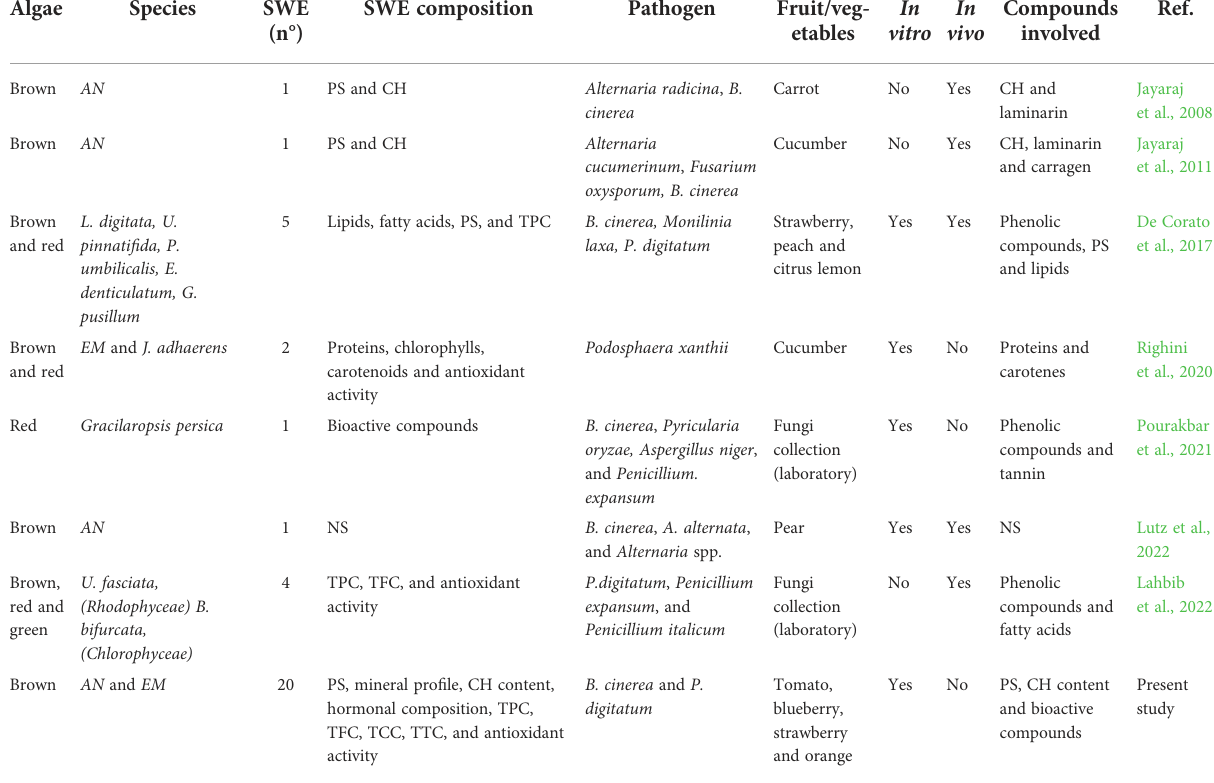
TABLE 4 Antifungal activity of SWEs reported in published